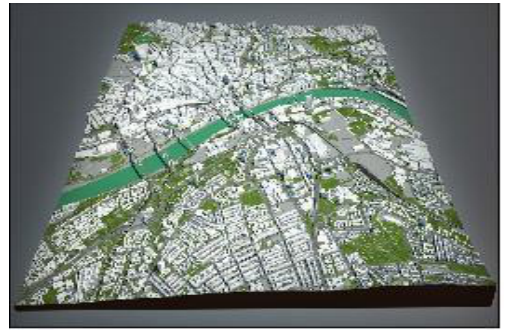
Fig.5- VNG Model extents. (Context Model